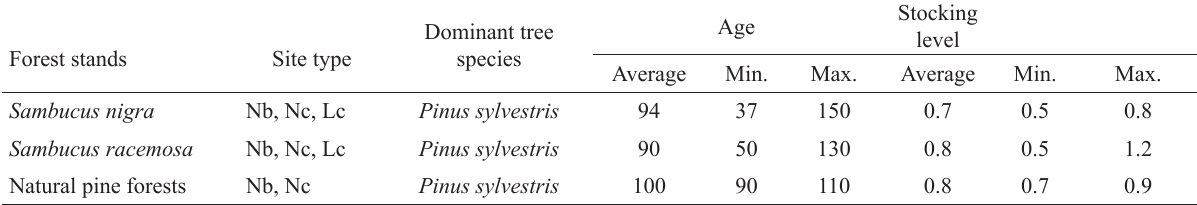
Table 1. Characteristics of forest with Sambucus sp. and natural pine forest stands. Abbreviations are: Nb, fresh poor soils; Nc, fresh fertile soils; Lc, moisture fertile soils. Stocking Age Dominant tree level Forest stands Site type species Average Min. Max. Nb, Nc, Lc Pinus sylvestris